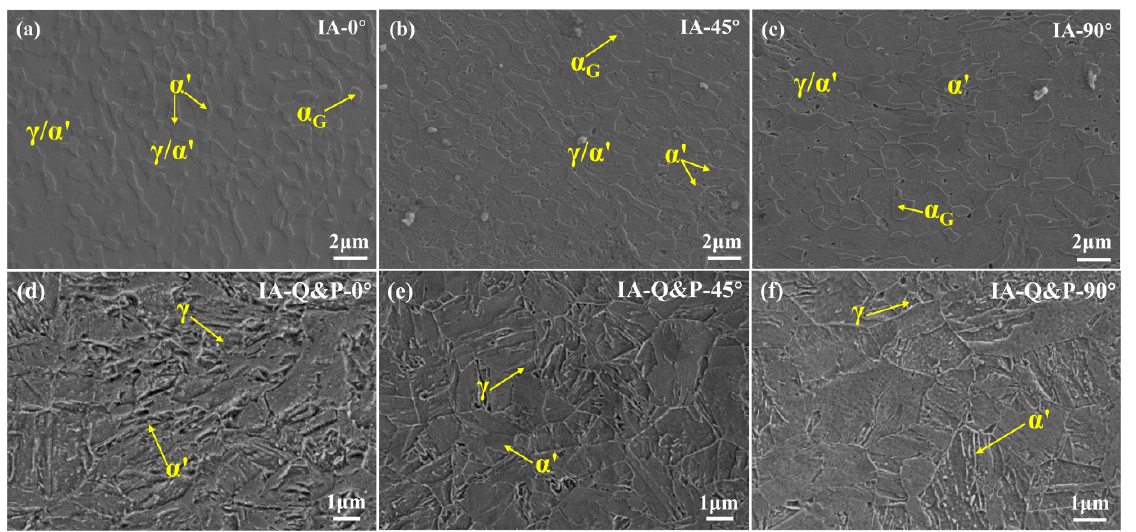
Figure 4. SEM images showing the deformed microstructure of ( a – c ) IA steel and ( d – f ) IA-Q&P steel after the uniaxial tensile test along the ( a , d ) 0°, ( b , d ) 45°, and ( c , f ) 90° directions with respect to the rolling direction. The microstructure is observed at the uniformly deformed region. α : ferrite, γ : austenite, α ’: martensite.